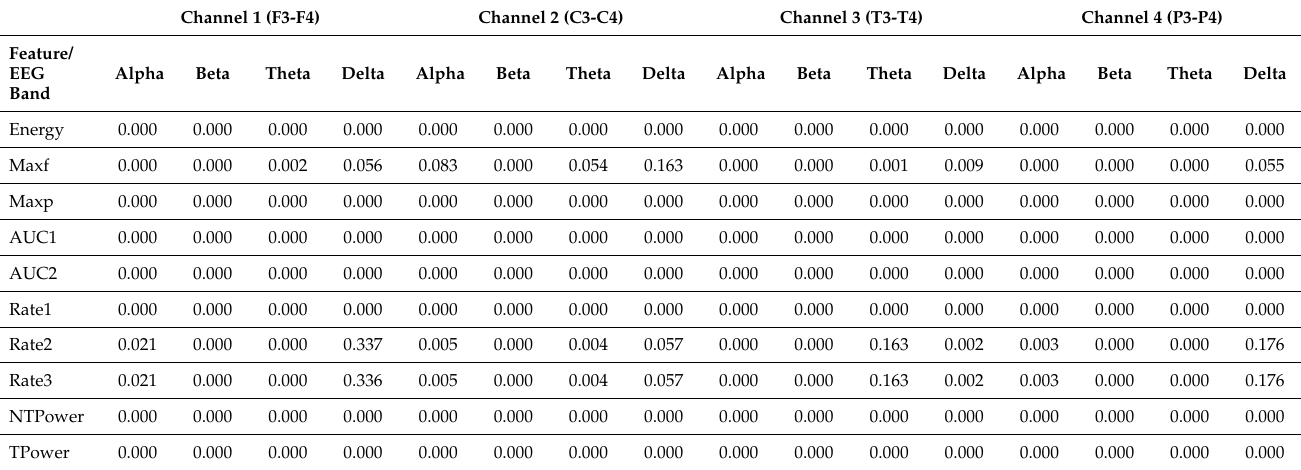
Table 5. Kruskal–Wallis test results.